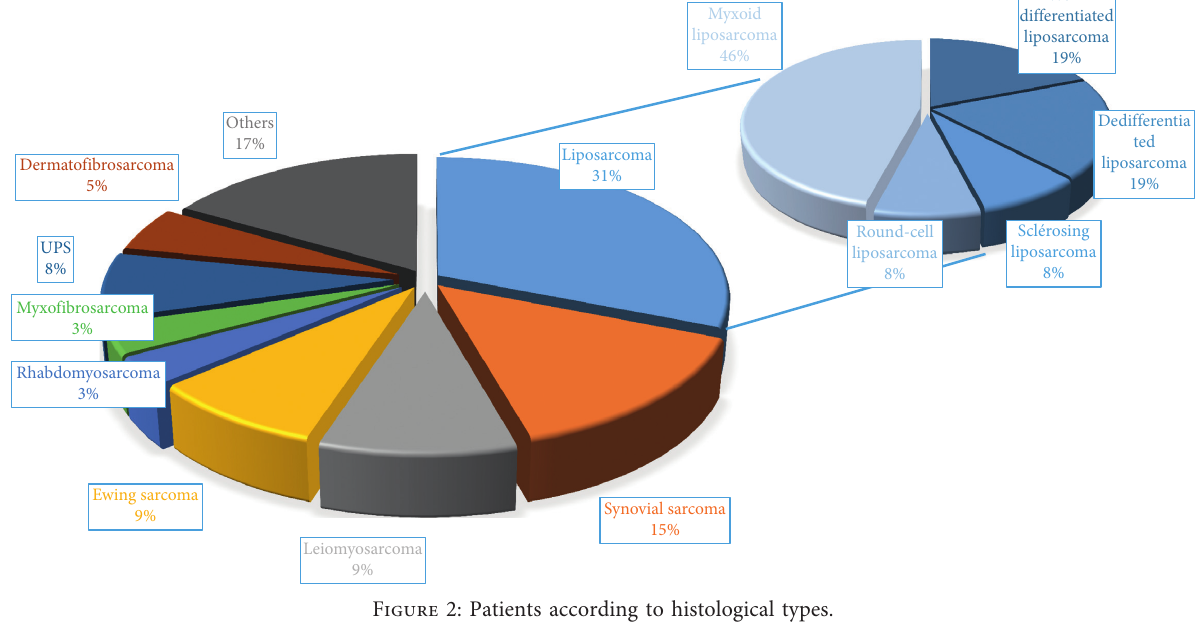
Figure 2: Patients according to histological